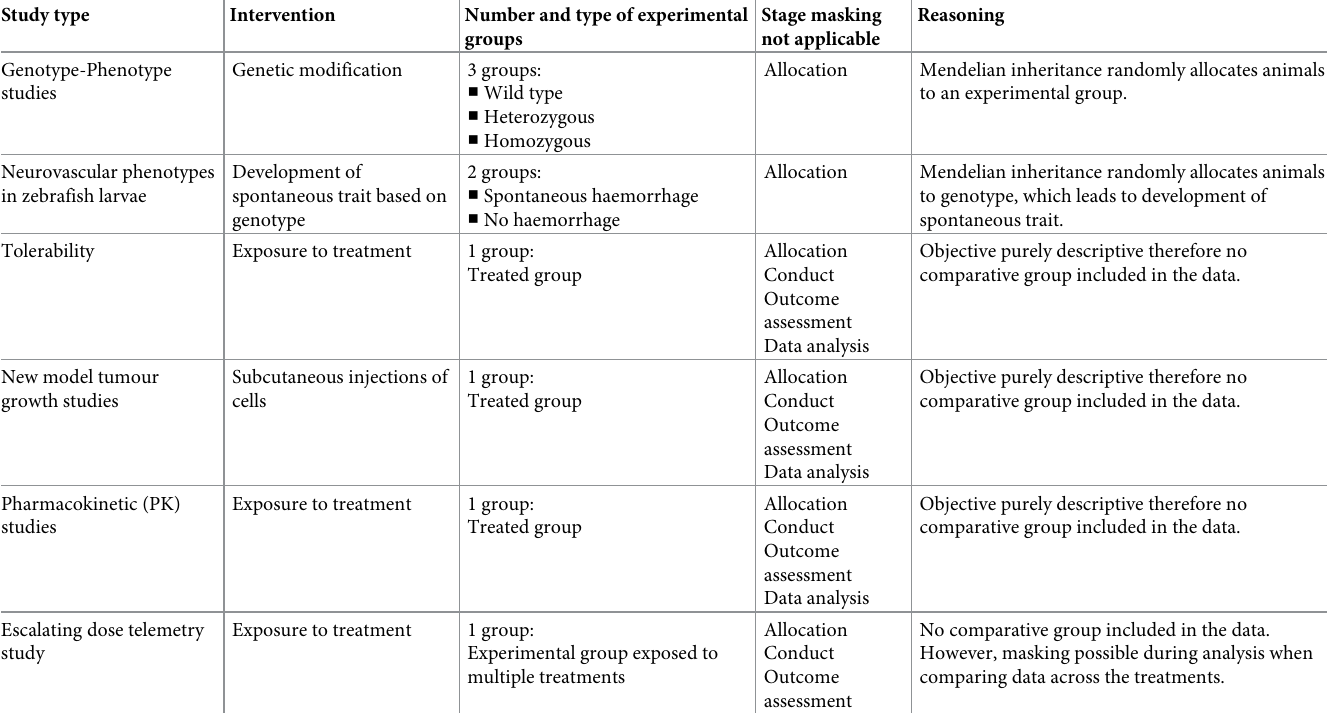
Table 2. Experimental scenarios identified during the interviews for which masking was not applicable (as assessed by the authors).